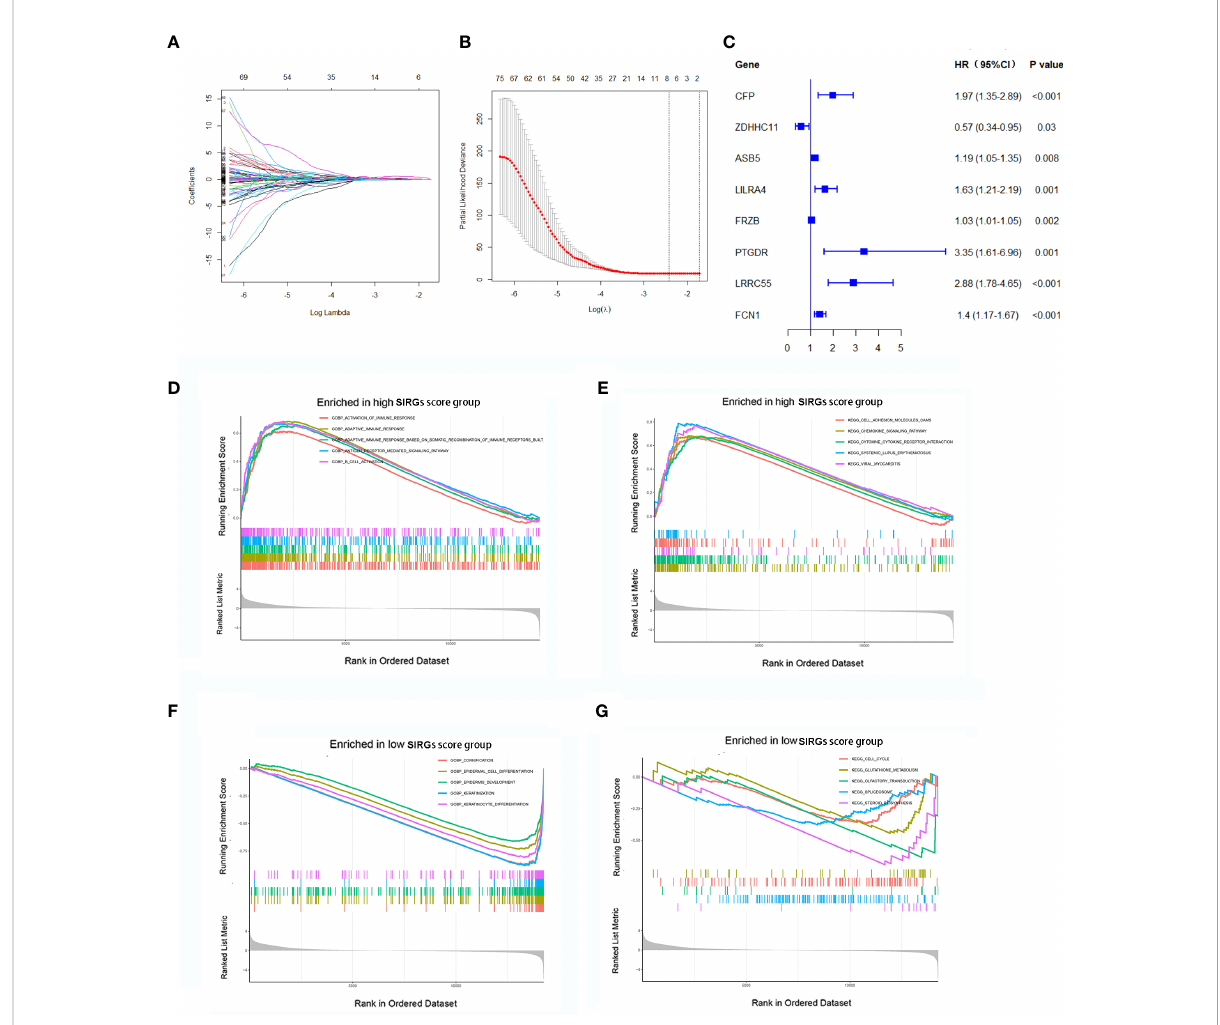
FIGURE 2 Construction of SIRGs score by LASSO analysis. (A, B) The LASSO Cox analysis identi fi ed that eight core SIRGs were associated with the prognosis of EGJA patients; (C) Forest plot of hazard ratios for eight core prognostic SIRGs; (D, E) GSEA analysis in high SIRGs score group; (F, G) GSEA analysis in high SIRGs score